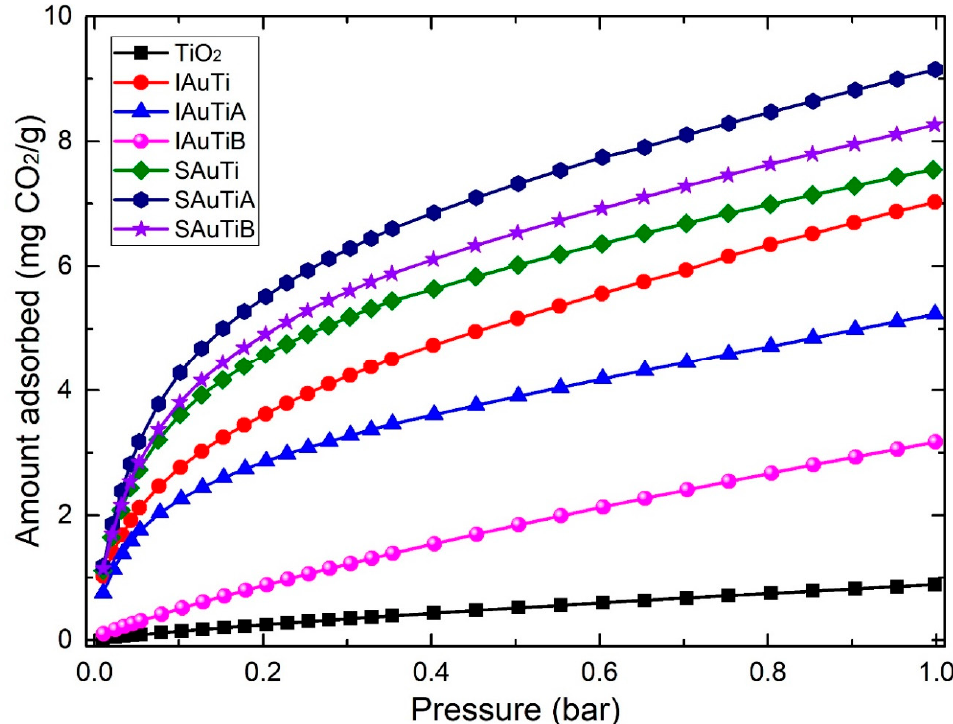
◦ C for materials of TiO